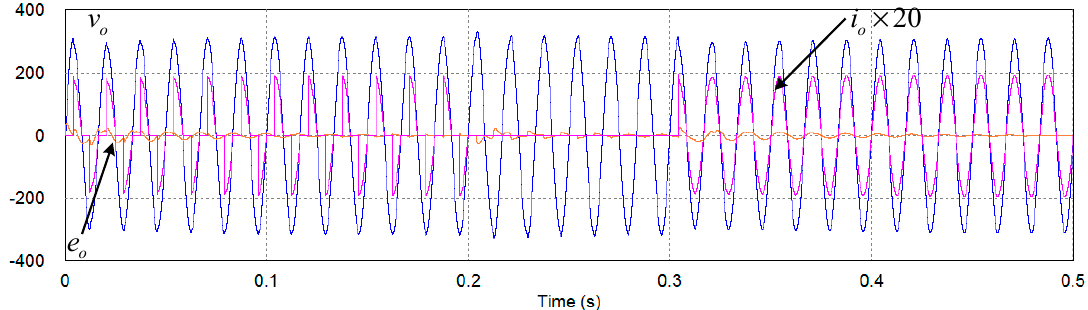
Figure 13. Simulation results of the UPS system with different load configurations.